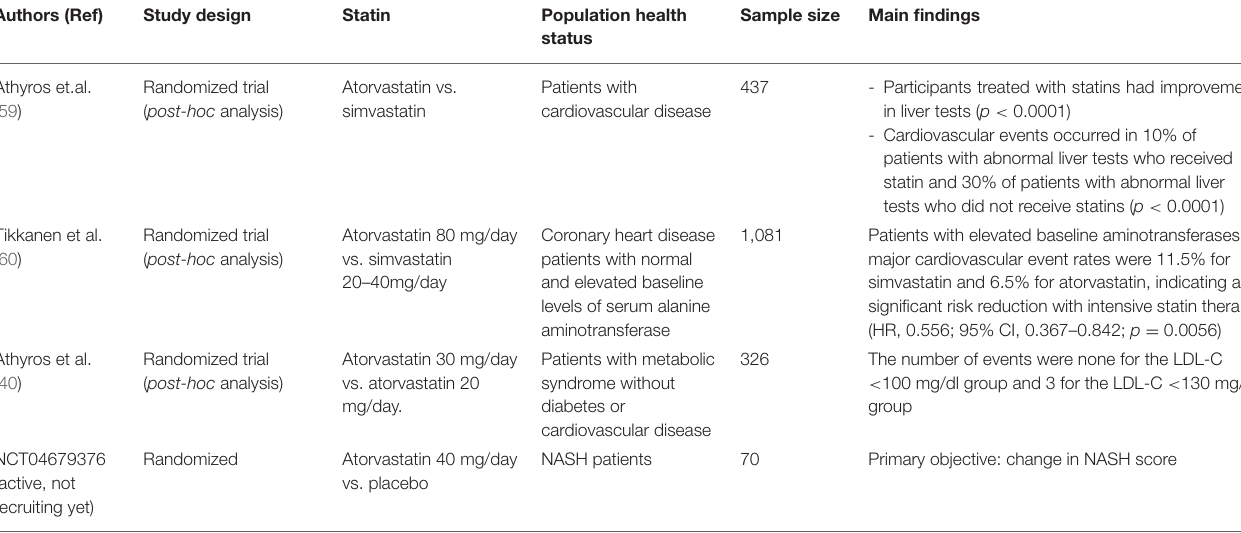
TABLE 1 | Summary of studies evaluating the effects of statin use in patients with NASH/NAFL. Authors